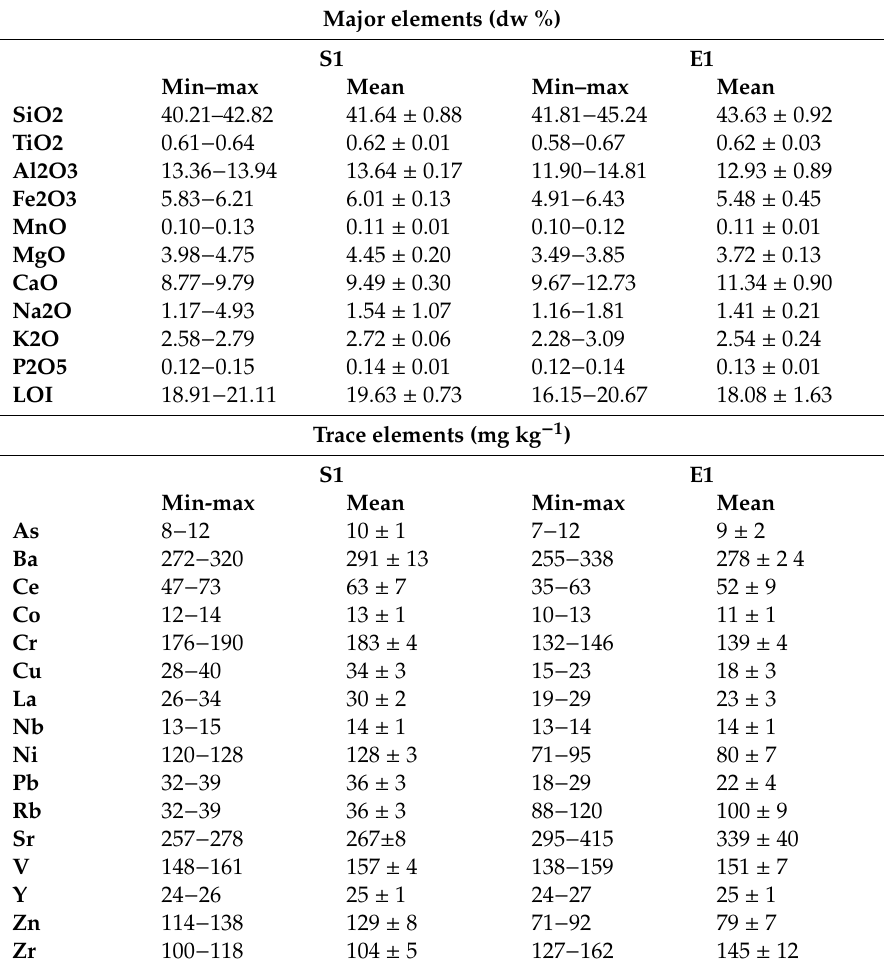
Table A1. Geochemical data from LTER-ANOC16